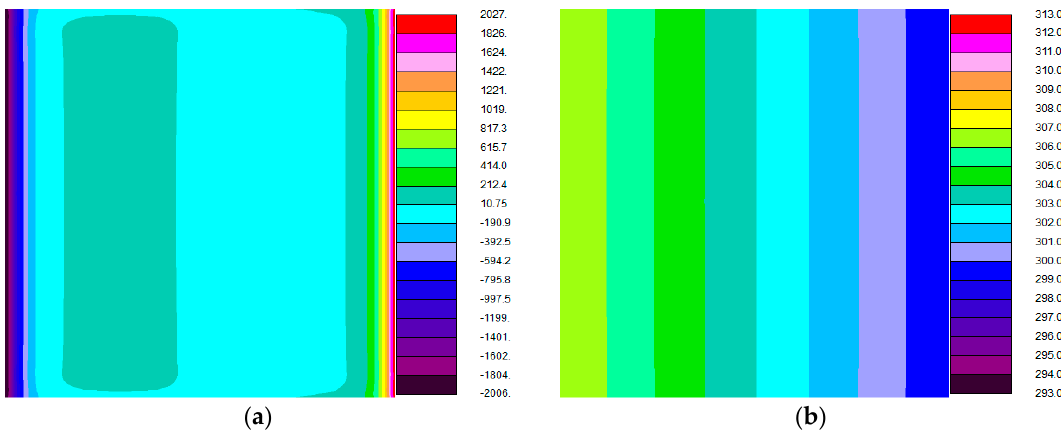
Figure 13. Counter-flow stainless-steel plate heat exchanger heat transfer model with LHC ( a ) The plate LHC heat flux distribution; ( b ) The plate temperature distribution.